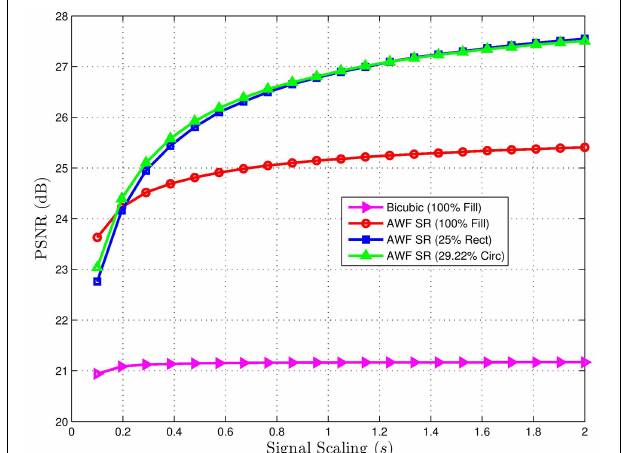
FIGURE 25 | PSNR for K = 16 multiframe AWF SR for the 8 bit motocross image (kodim05.png) vs. square detector width a , and signal scaling parameter s . The system parameters are the Q = 0 . 50 row in Table 1 . Note that for high signal levels (larger s ), the optimum a is close to 15 μ m (with zero at the optical cutoff frequency 66 . 67 cyc/mm). However, for very low signals levels (small s ), larger active areas are preferred.